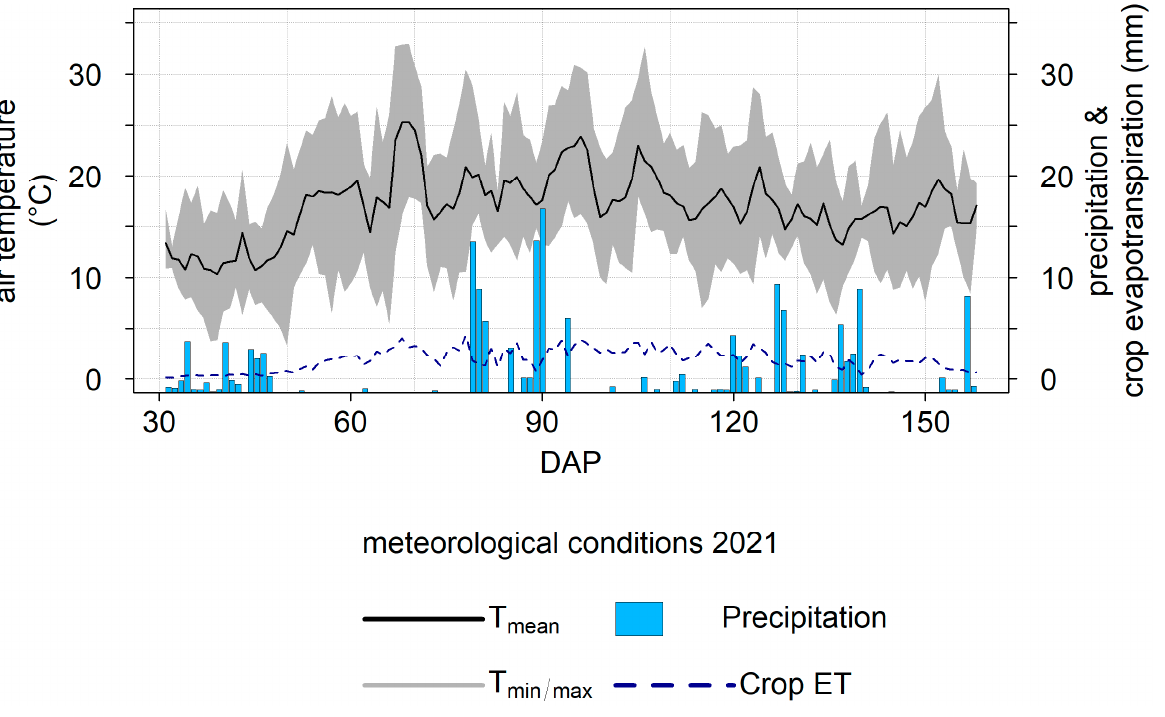
Figure 1. Measured agrometeorological data during the 2021 growing season (12 May 2021, until 16 September 2021): DAP = days after planting; T mean = mean daily air temperature (°C); T min = minimum daily air temperature (°C); T max = maximum daily air temperature (°C); Crop ET = in situ derived crop evapotranspiration (mm) determined based on the energy budget on the site according to the FAO crop evapotranspiration [40]. Crops were planted on 15 April 2021. Data were measured in four replicates on the study site and validated using a nearby climate station. Measurement devices were installed over the entire irrigation lane on 5 May 2021 (20 DAP) and uninstalled on 16 September 2021 (154 DAP).